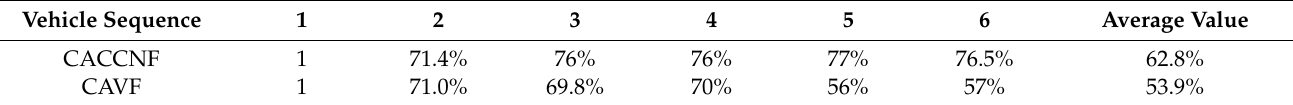
Table 6. Comfort degree of CAVF fleet and CACCNF fleet.